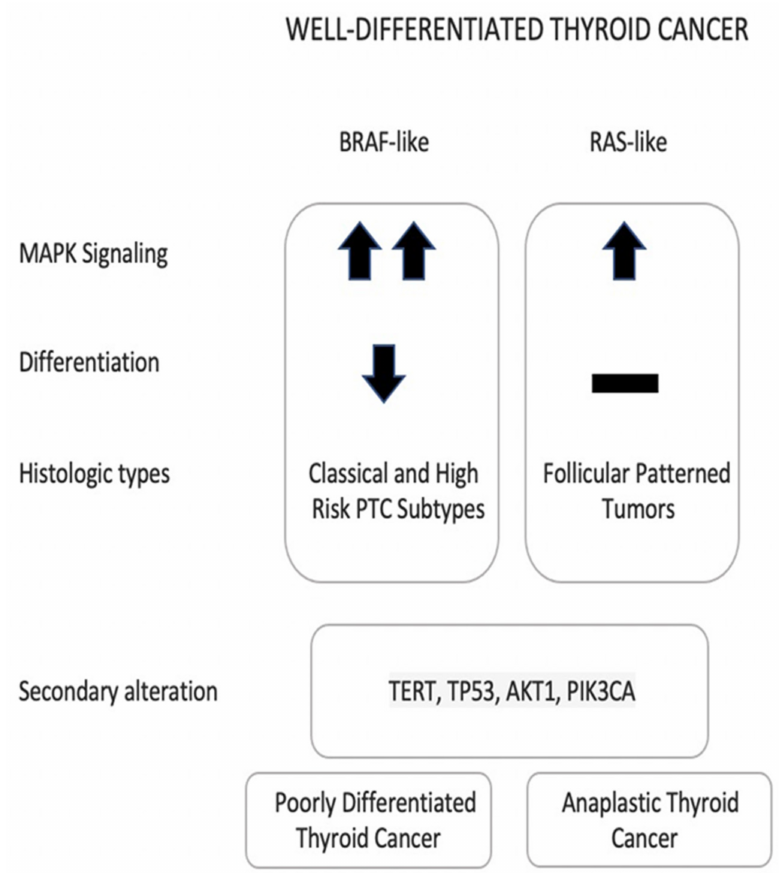
Figure 1. The Consequences of BRAF-like and RAS-like Molecular Alterations in Thyroid Carcinoma. Abbreviations: ( ↑ ): Upregulated MAPK pathway output in RAS-like tumors; ( ↑↑ ): BRAF-like tumor has a Higher MAPK pathway output than RAS-like tumors; ( ↓ ): Less differentiated; (-): Retained differentiation. Acquiring secondary alterations results in dedifferentiation and aggressive